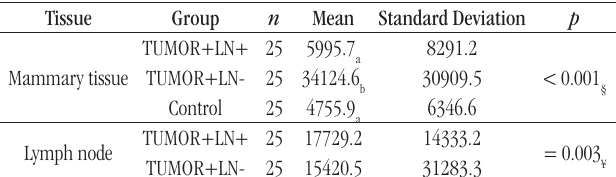
taBLE 2 − Hsp27 expression in mammary tissue and sentinel lymph node for TUMOR+LNF+ and TUMOR+LNF- groups and the control group by quantitative analysis (values in µm 2 ) Tissue Group n Mean Standard Deviation p